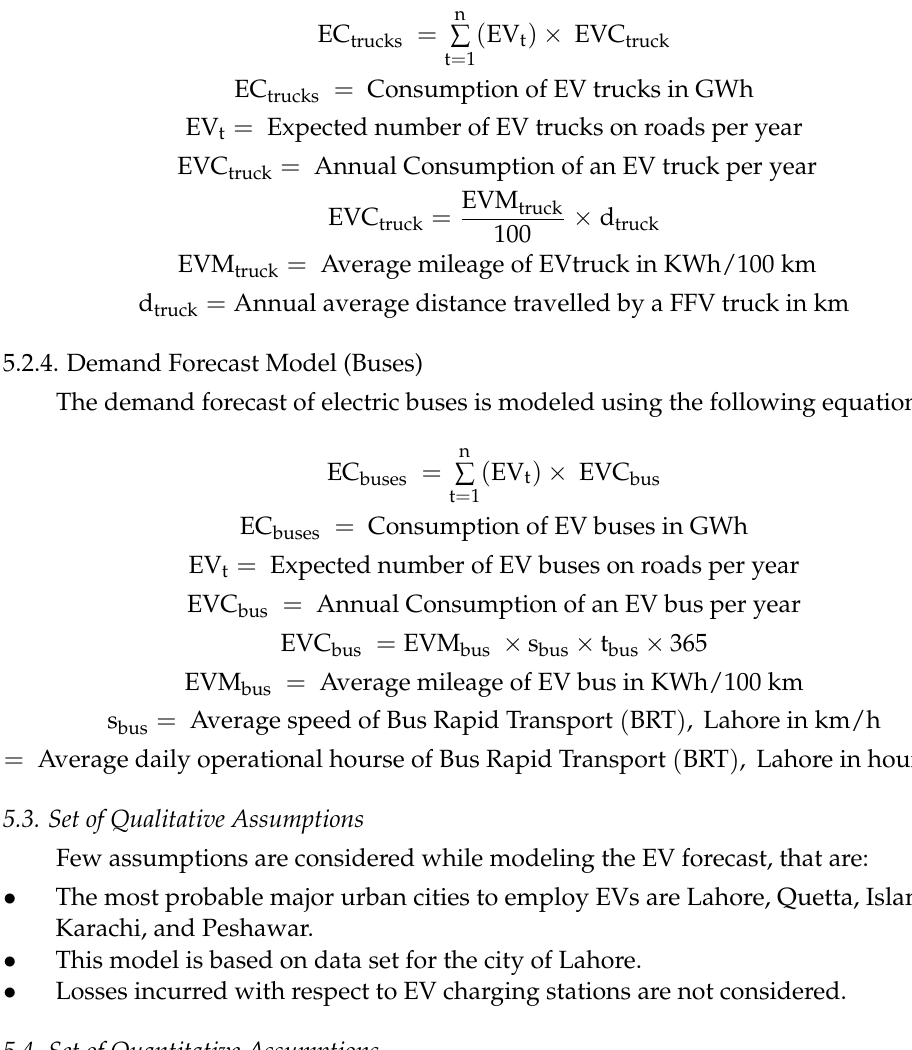
Table 2 titled: “NTDC Plant Capacity” represents the summary of power balances